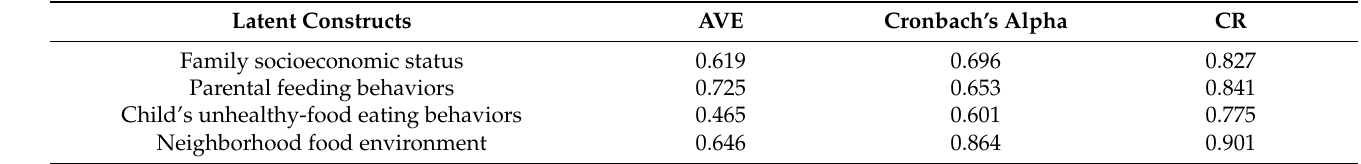
Table 2. The average variance extracted (AVE), Cronbach’s alpha, and composite reliabilities of the latent constructs in the model of neighborhood food environment correlates of childhood and adolescent obesity.